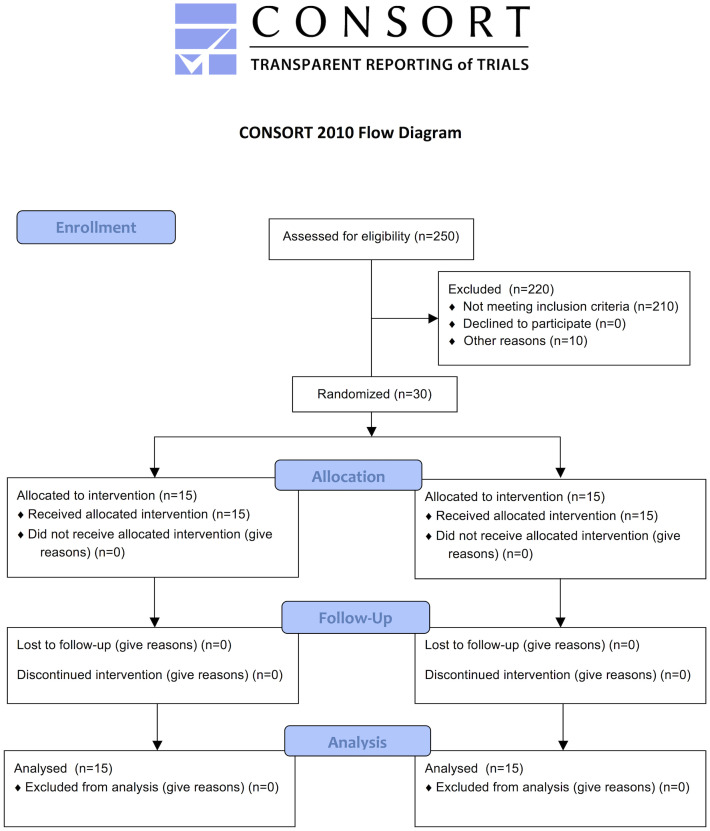
Flowchart of the study design.